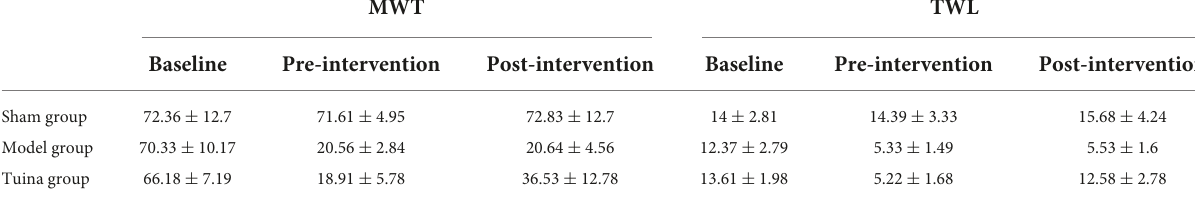
TABLE 1 Results of behavioral tests of rats in each group. MWT TWL Baseline Pre-intervention Post-intervention Baseline